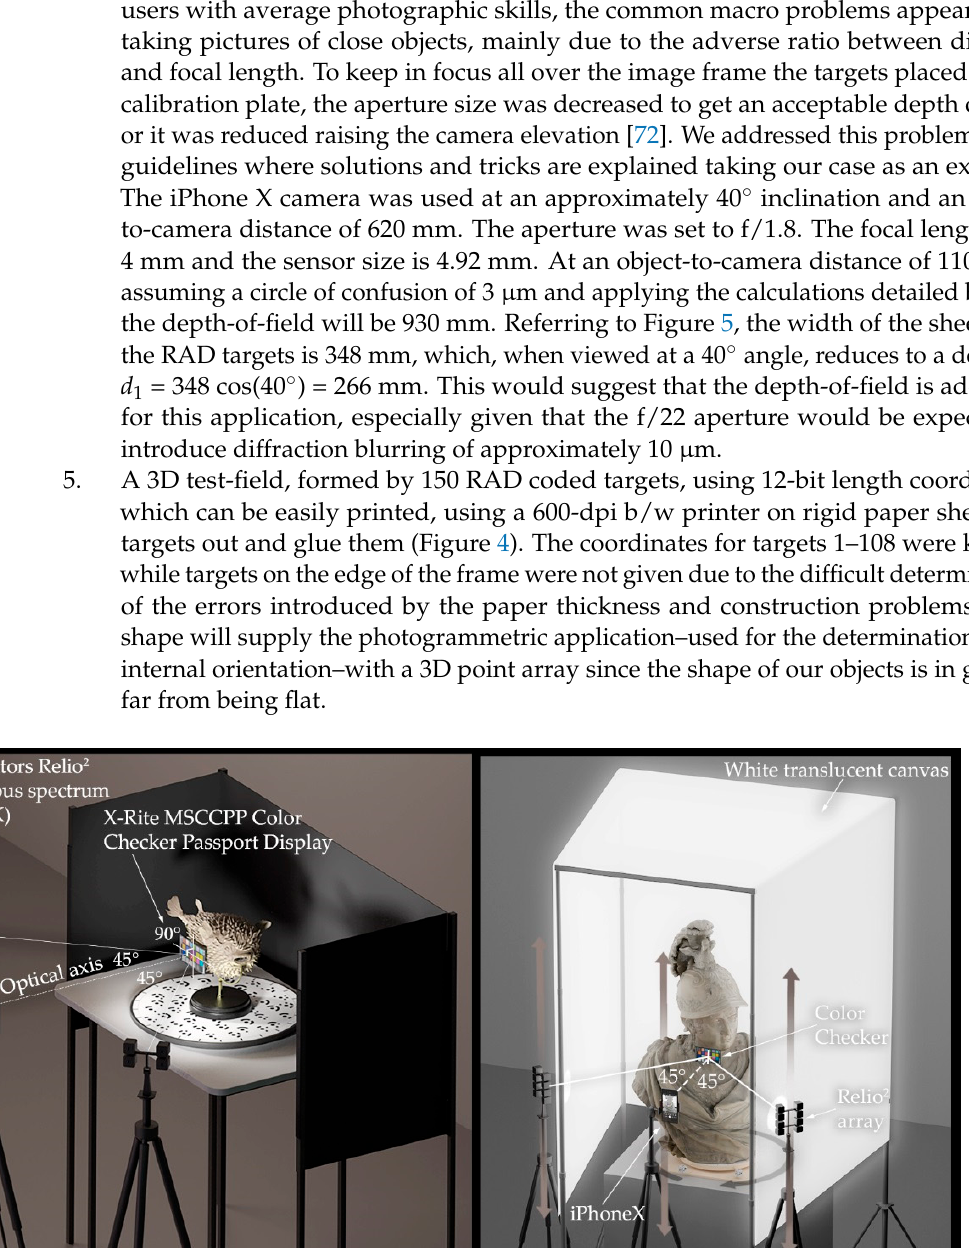
Figure 4. Main issues to ensure an appropriate depth of field using iPhone X.